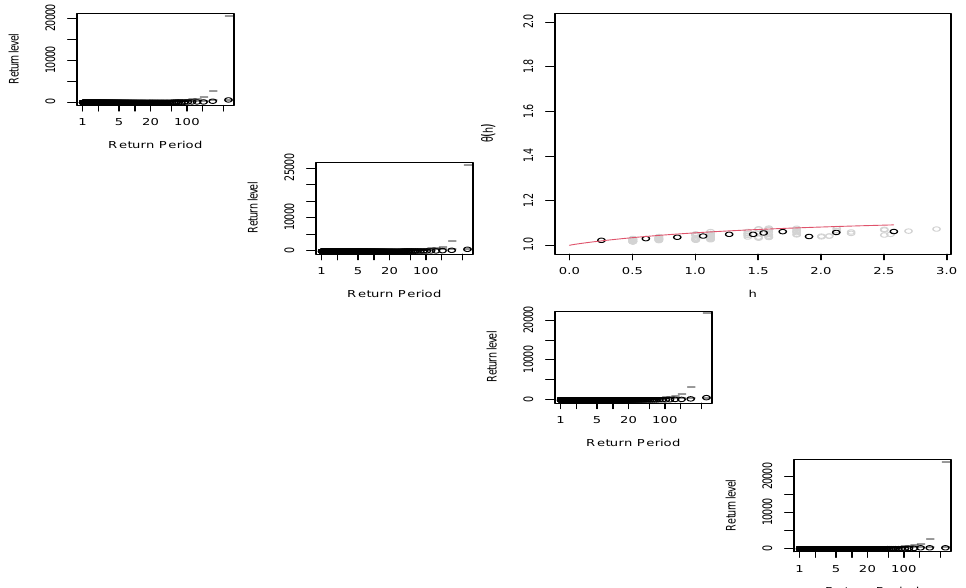
Figure A4. Diagnostic plots of the max-stable process fitted to the first cluster of annual maximum temperature with a generalised Cauchy covariance